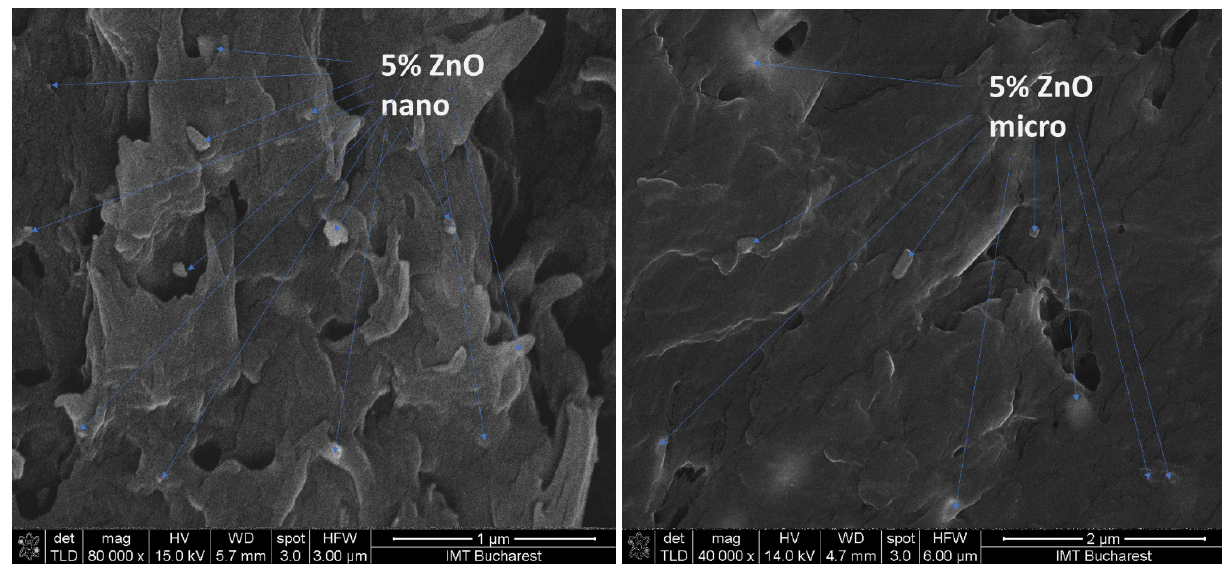
Figure 4. High magnification FESEM for the 5% ZnO nano- and micro- samples; 5% nano ZnO-ABS × 80,000; 5% micro ZnO-ABS × 40,000.